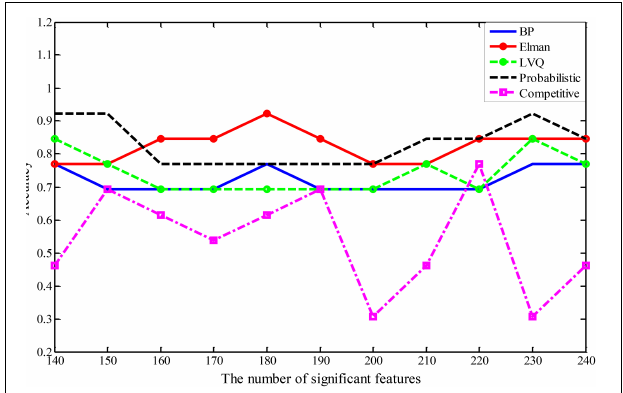
FIGURE 3 | The accuracies of five different types of random neural network